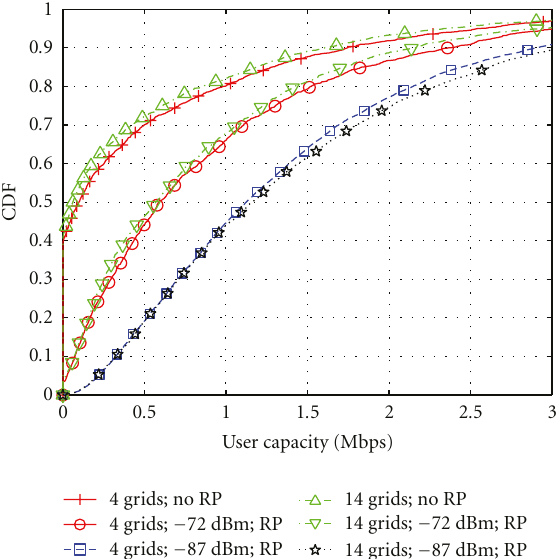
Figure 7: CDFs showing femto downlink user capacity for a system with resource partitioning compared against a system without resource partitioning.